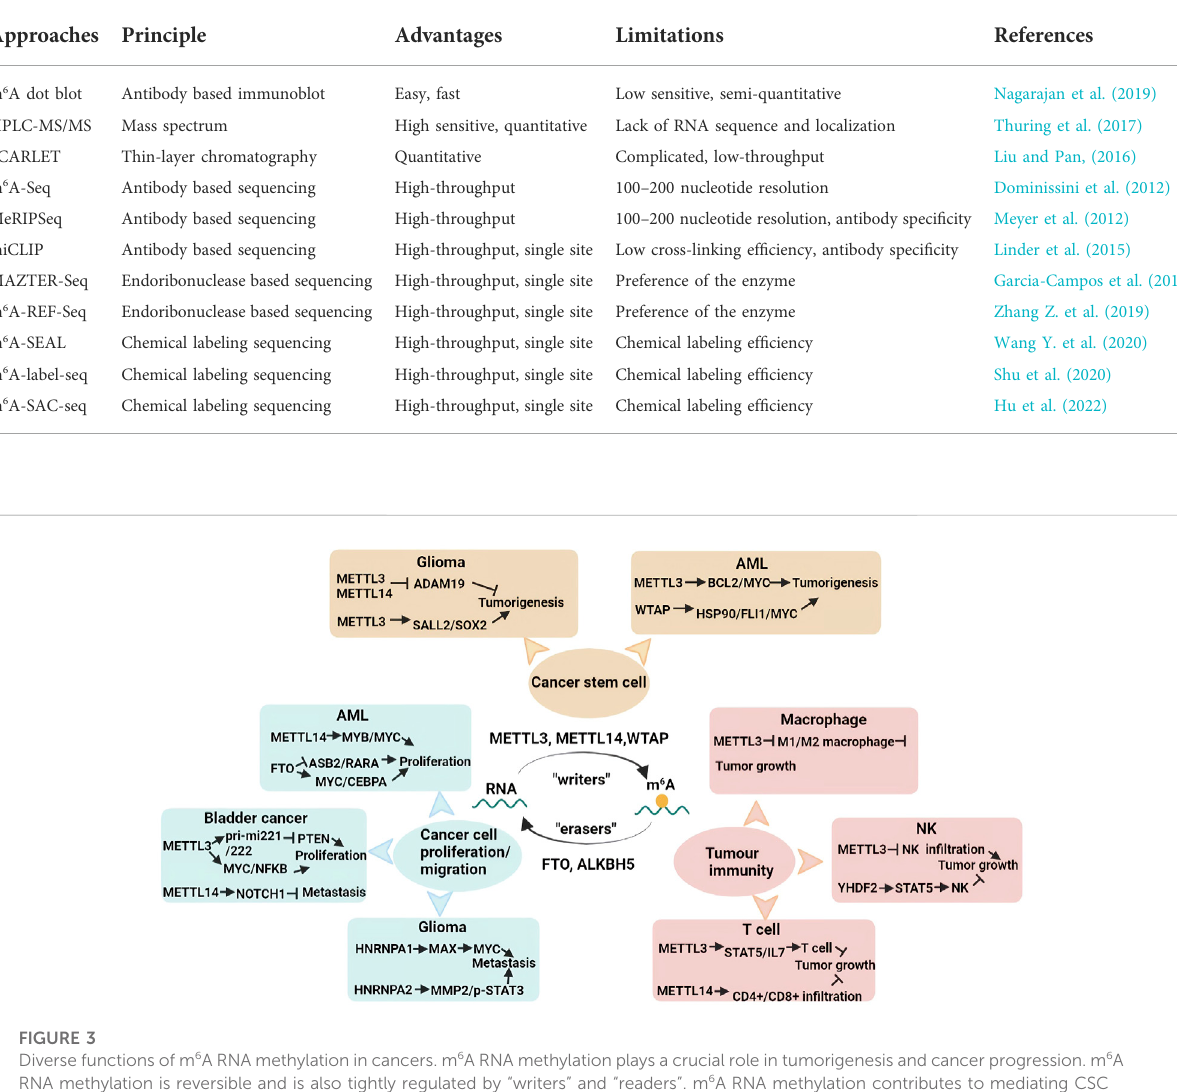
TABLE 1 Approaches for the detection of m 6 A RNA methylation.